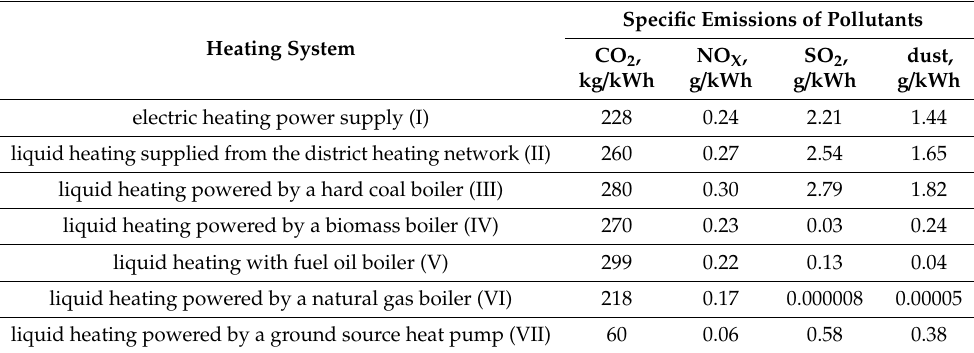
Table 4. Specific emissions from individual heating systems.